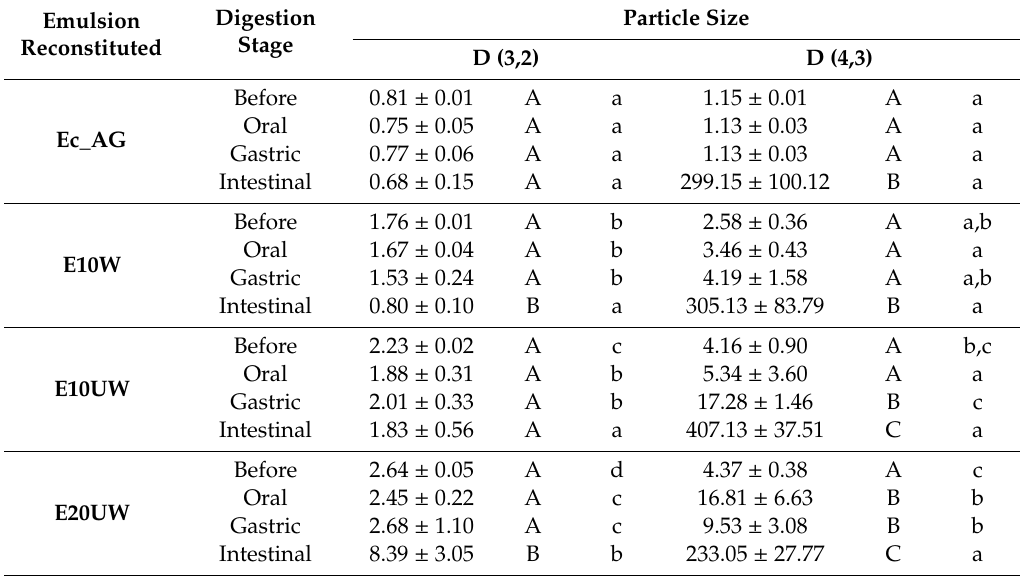
Table 2. Oil droplet size distribution statistics in reconstituted emulsions before in vitro digestion and after the oral, gastric and intestinal phase of the INFOGEST